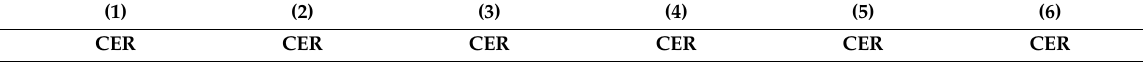
Table 7. The results of the endogenous